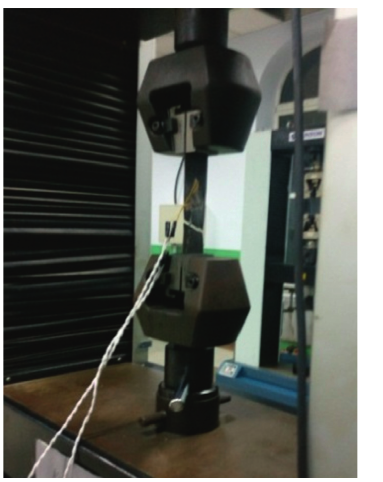
Figure 4: Tensile test of steel. Table 2: Tensile properties of steel.